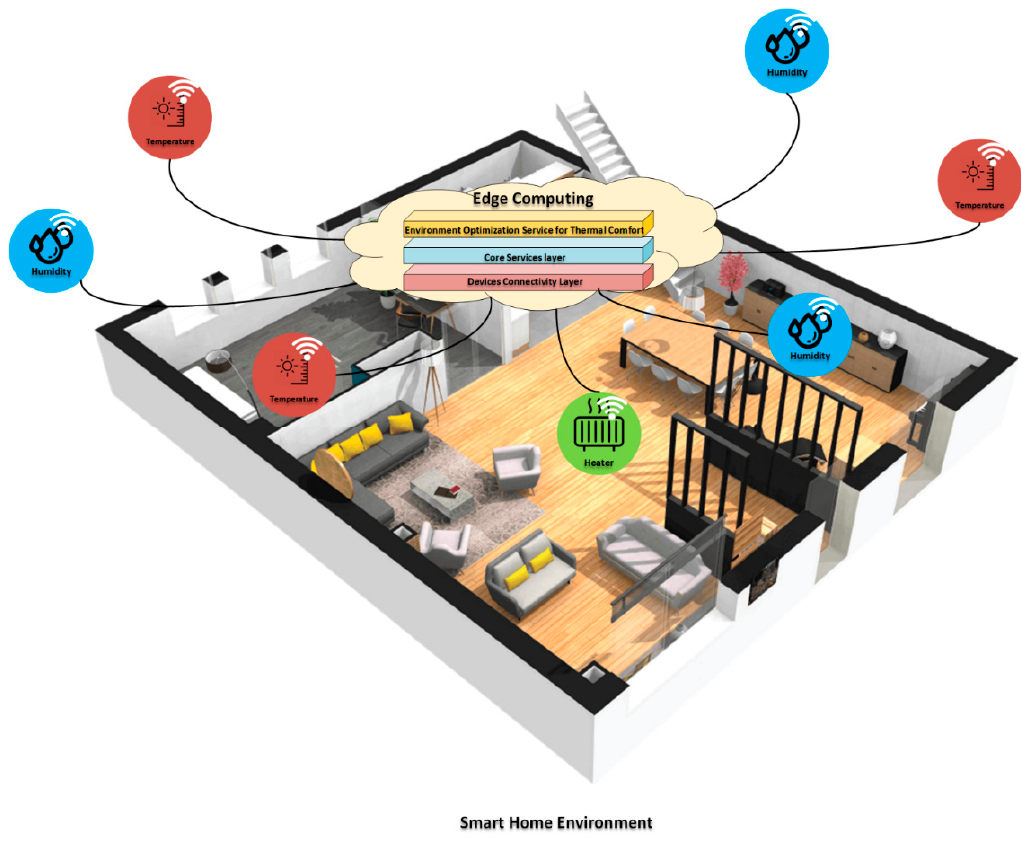
Figure 1. Conceptual Smart Home Environment of Edge Computing for Efficient Thermal Comfort Control.